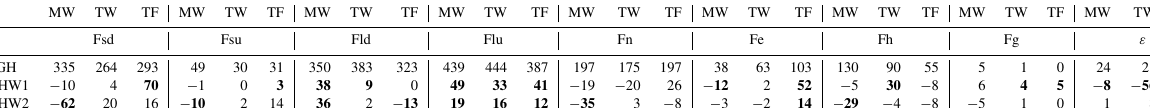
Table 2. Statistics of radiation and energy exchange for the ecosystems Mediterranean woodlands (MW), temperate woodlands (TW) and temperate forests (TF) and the variables flux of shortwave downward radiation (Fsd), shortwave upward radiation (Fsu), longwave downward radiation (Fld), longwave upward radiation (Flu), net radiation (Fn), latent heat (Fe), sensible heat (Fh), ground heat (Fg) and the energy imbalance ( ε) . Where values during the two periods of the heat wave ( (cid:49) HW1 and (cid:49) HW2) differ significantly from the background (BGH; P <0.1) this is indicated by bold fonts.